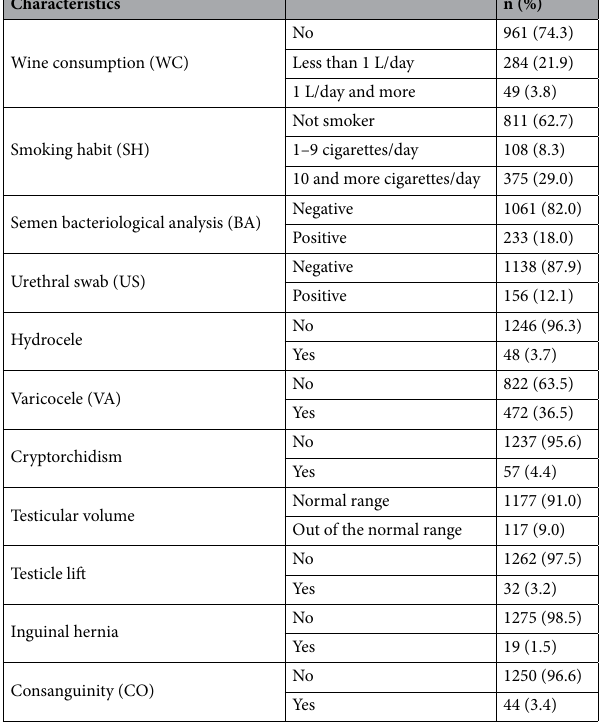
Fertility index 3,838,491.383 ± 14,797,996.282 412,010.286 3,030,207.098 4,646,775.668 7,386,079.7 ±